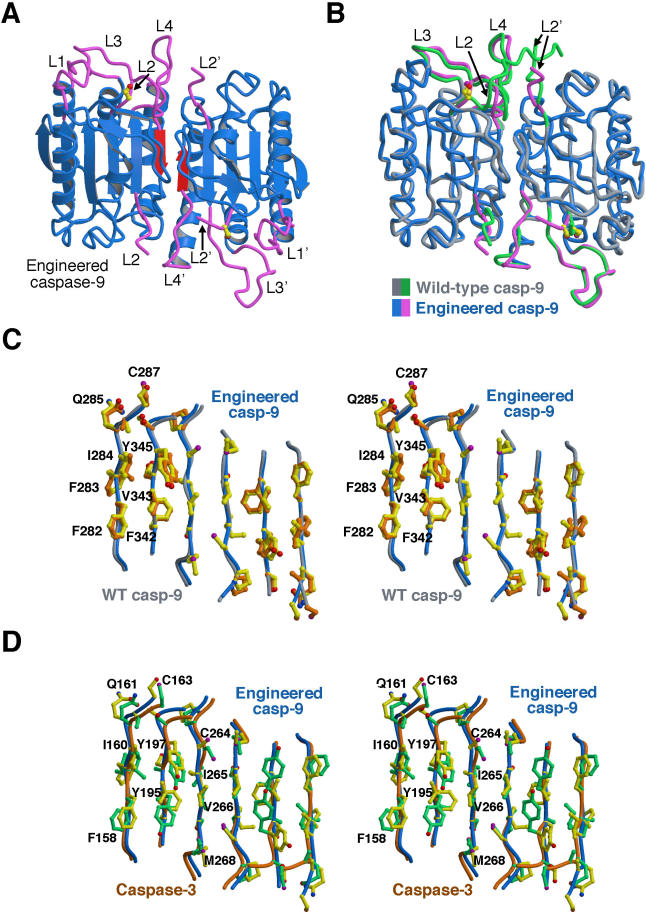
The Dimeric Caspase-9 Closely Resembles the WT Caspase-9(A) Overall structure of the dimeric caspase-9 (C287S). The structural core is shown in blue; the solvent-exposed active site loops are shown in magenta. The β6 and β6′ strands are highlighted in red. Note the asymmetry of the dimer.(B) Structural superposition of the dimeric caspase-9 (blue and magenta) and the WT caspase-9 (grey and green). The only significant structural difference is in the solvent-exposed active site loops, which is due to the inactive nature of the dimeric caspase-9 (C287S).(C) A stereo comparison of the region surrounding strands β6 and β6′ in WT and dimeric (engineered) caspase-9. The side chains of the WT and dimeric caspase-9 are shown in orange and yellow, respectively. To avoid congestion in the graphic, residues from only one caspase-9 monomer are labeled. The Cys287 in the upper left corner is the catalytic residue in the active site of the asymmetric caspase-9.(D) A stereo comparison of the region surrounding strands β6 and β6′ in caspase-3 and dimeric (engineered) caspase-9. The side chains of the caspase-3 and dimeric caspase-9 are shown in green and yellow, respectively. The labels refer to amino acids in caspase-3.